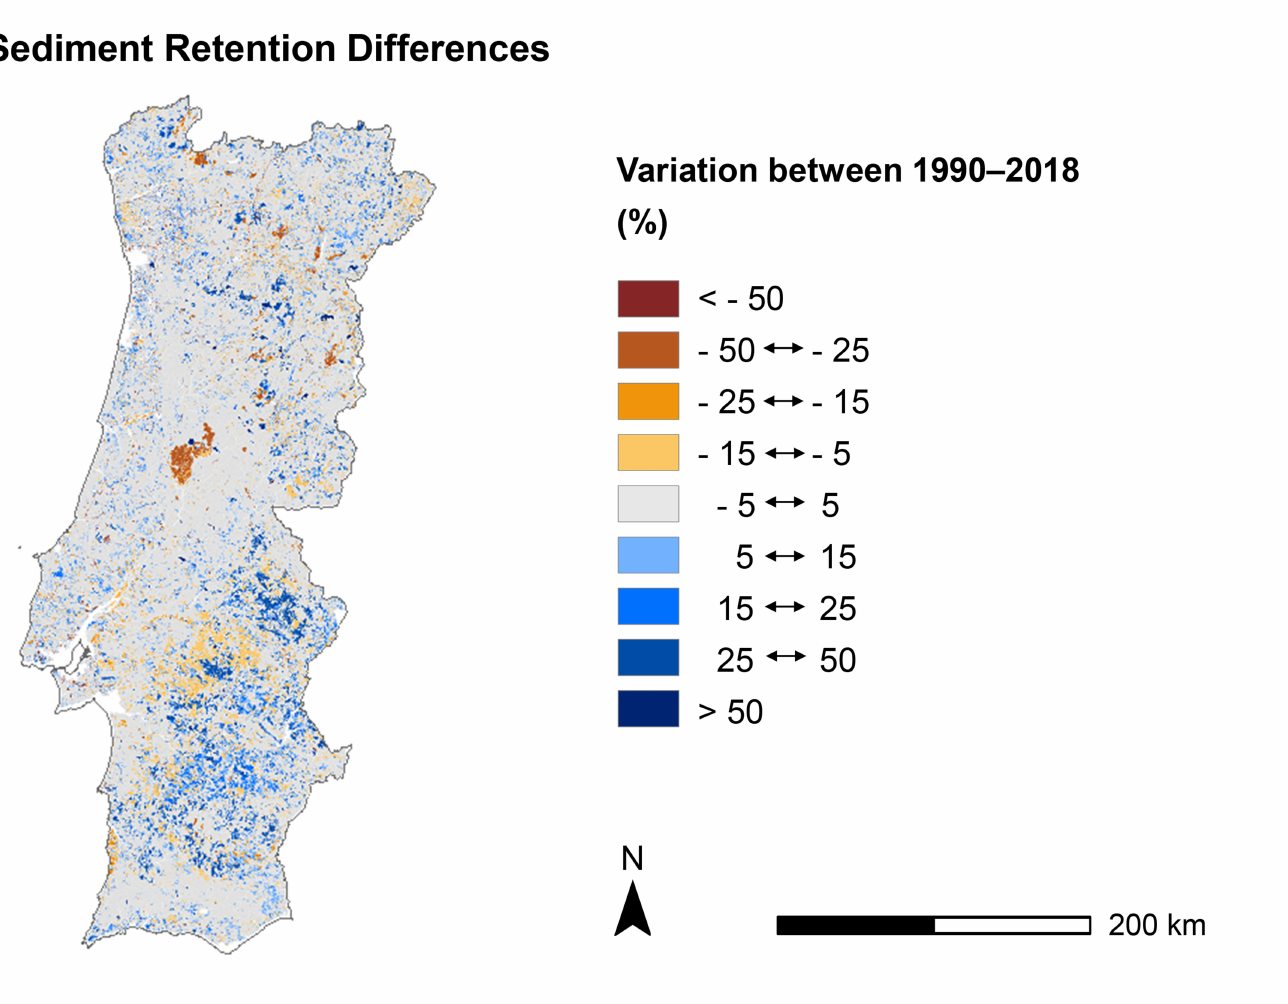
Figure 3. Sediment retention differences in mainland Portugal between 1990 and